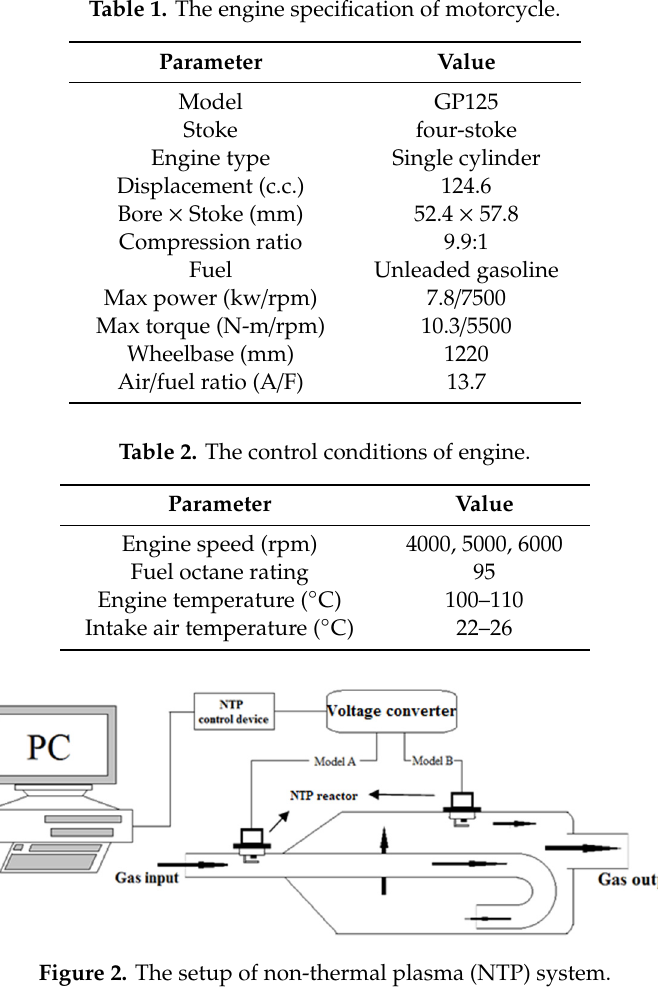
Figure 3. Photographic view of the device set up on ( a ) model A and ( b ) model B of the experimental motorcycle. 2.2. Experimental Procedure The measurement equipment was adjusted and corrected before the experiment began. The preparation and measurement procedures were as follows: